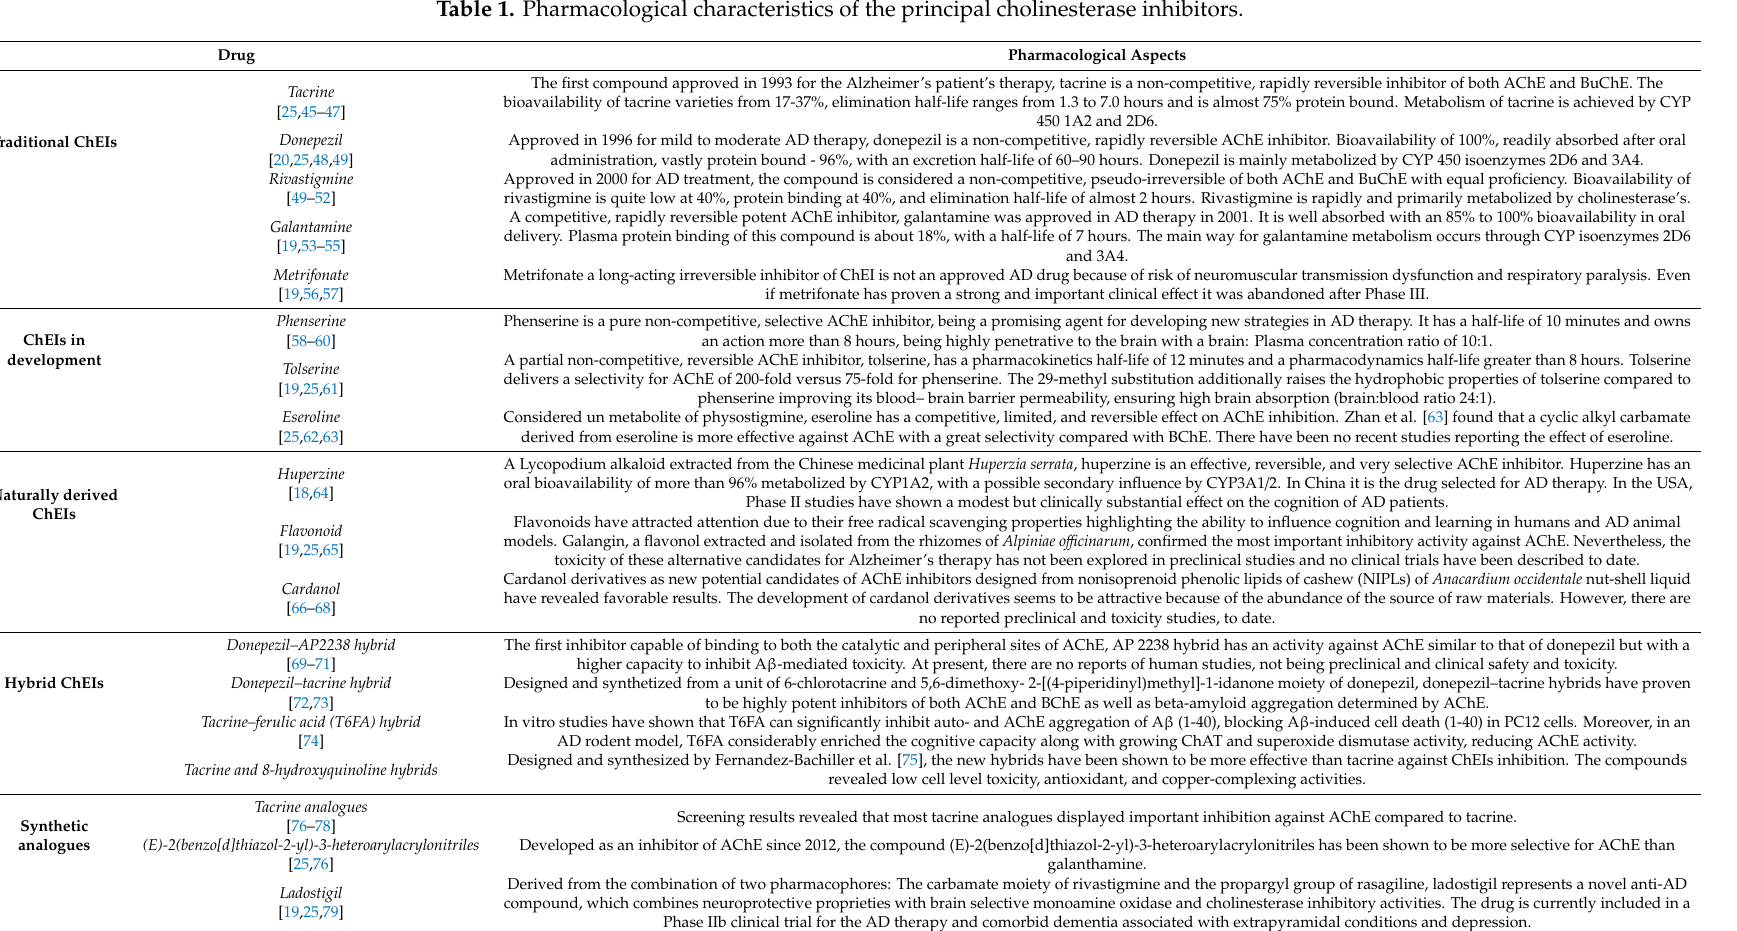
Table 1. Pharmacological characteristics of the principal cholinesterase